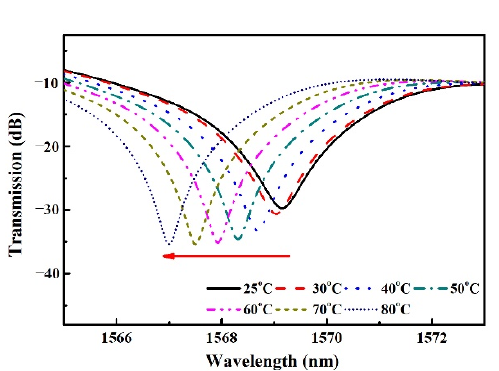
Figure 3. Transmission spectra at different temperatures.